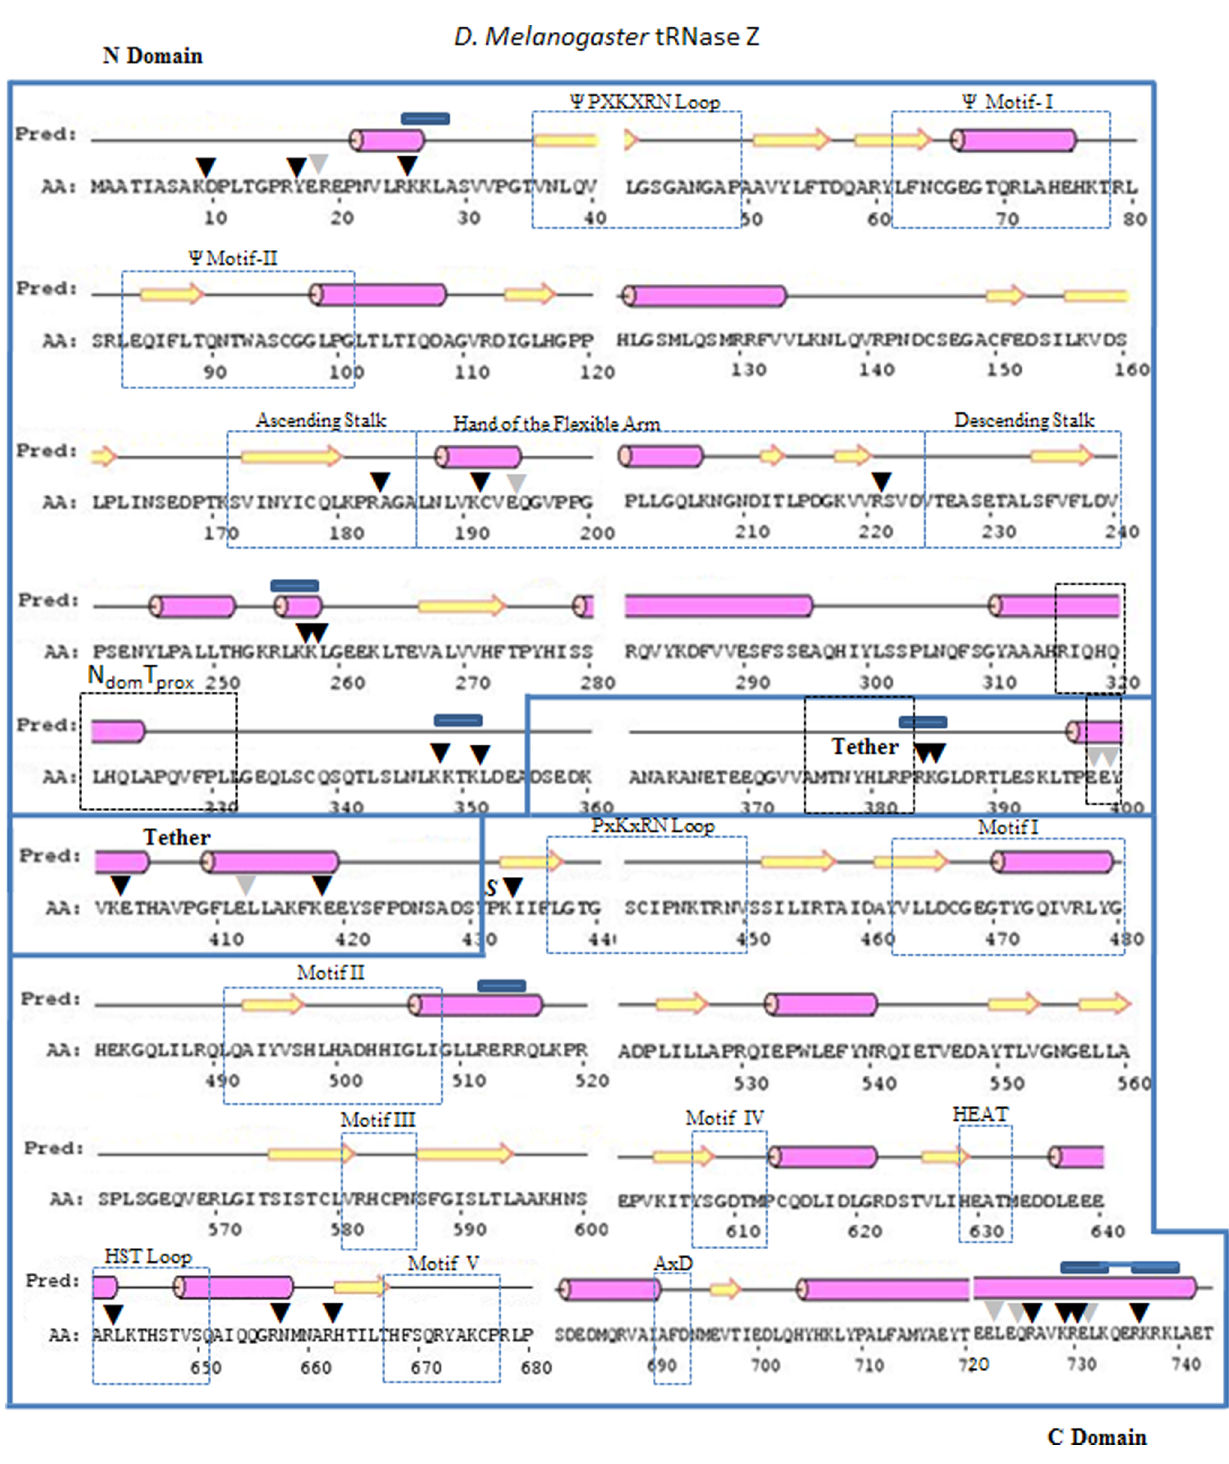
Figure 4. Sequence and predicted secondary structure of D.melanogaster tRNase Z (Psipred). Large rectangular enclosures indicate amino domain, tether and carboxy domain. Dashed rectangular enclosures indicate functionally characterized motifs (discussed in detail and further annotated with a multiple sequence alignment in Supplemental Figure SF2 in File S1). doi:10.1371/journal.pone.0066942.g004 spectrometry. Sensitivity of the MALDI-ion trap mass spectrom- peptides can be analyzed by mass spectrometry using higher etry instrument in MS/MS mode [39,40] allows identification of resolution single-stage MS to obtain peptide mass maps of each low abundance polypeptides at the boundaries of the limited limited proteolysis product, as well as tandem MS (MS/MS) to proteolysis polypeptides, and the offline, stable nature of MALDI confirm peptide sequence, both using MALDI-ion trap mass